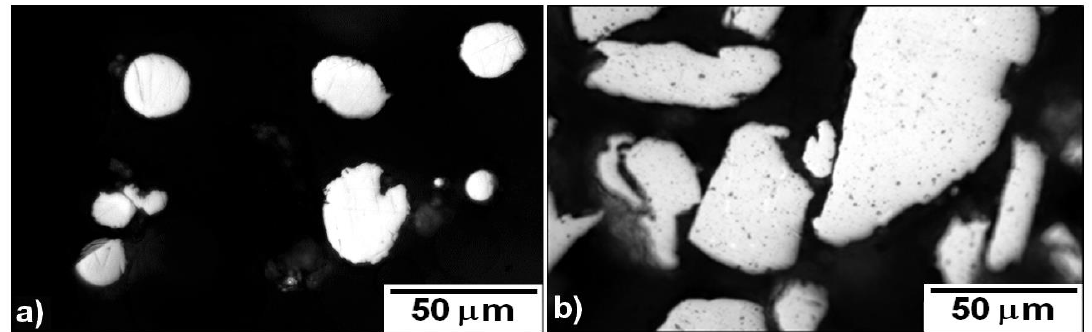
Figure 2. Optical micrographs of Fe28Al powder particles: ( a ) original and ( b ) 1-h milled. Detailed observation by SEM confirmed changes in the morphology of powder particles. The